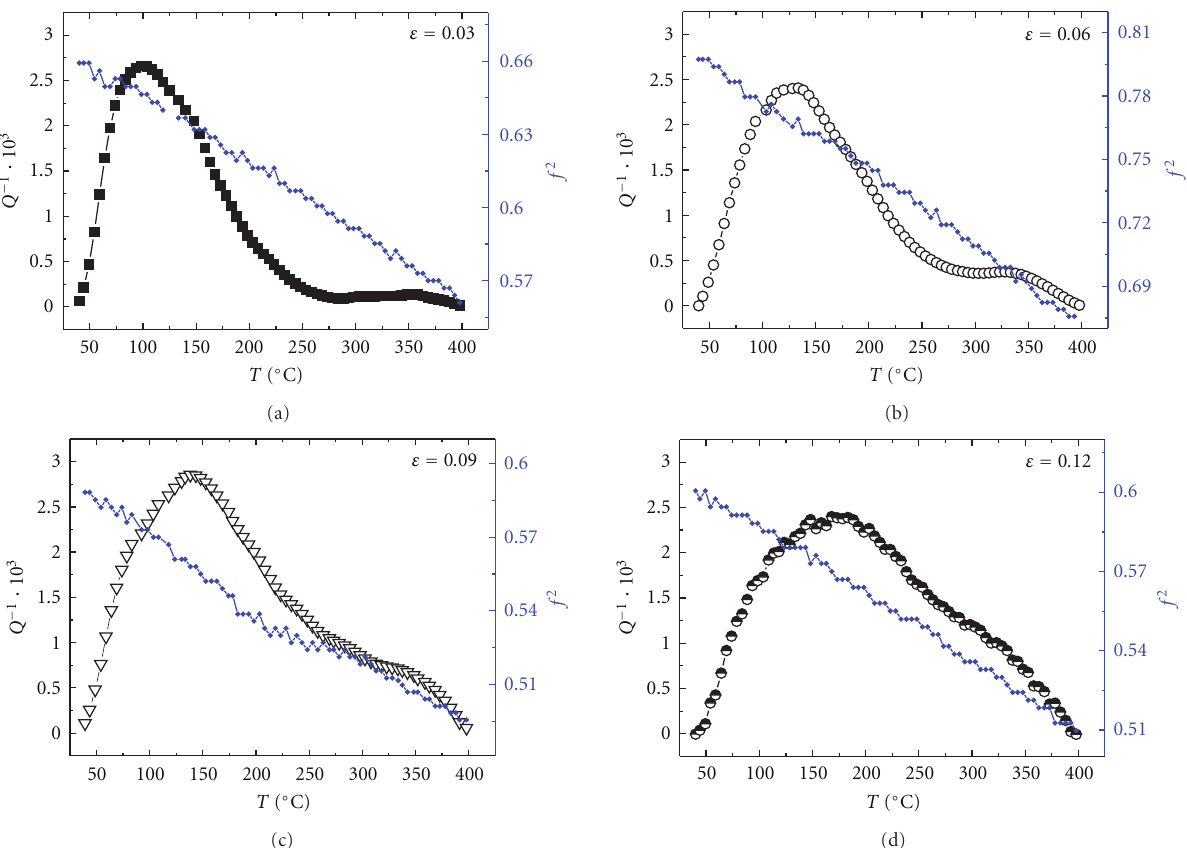
Figure 6: Internal friction spectra of samples with previous tensile true strain from 0.03, 0.06, 0.09, and 0.12 introduced at − 50 ◦ C showing the measured frequency at square